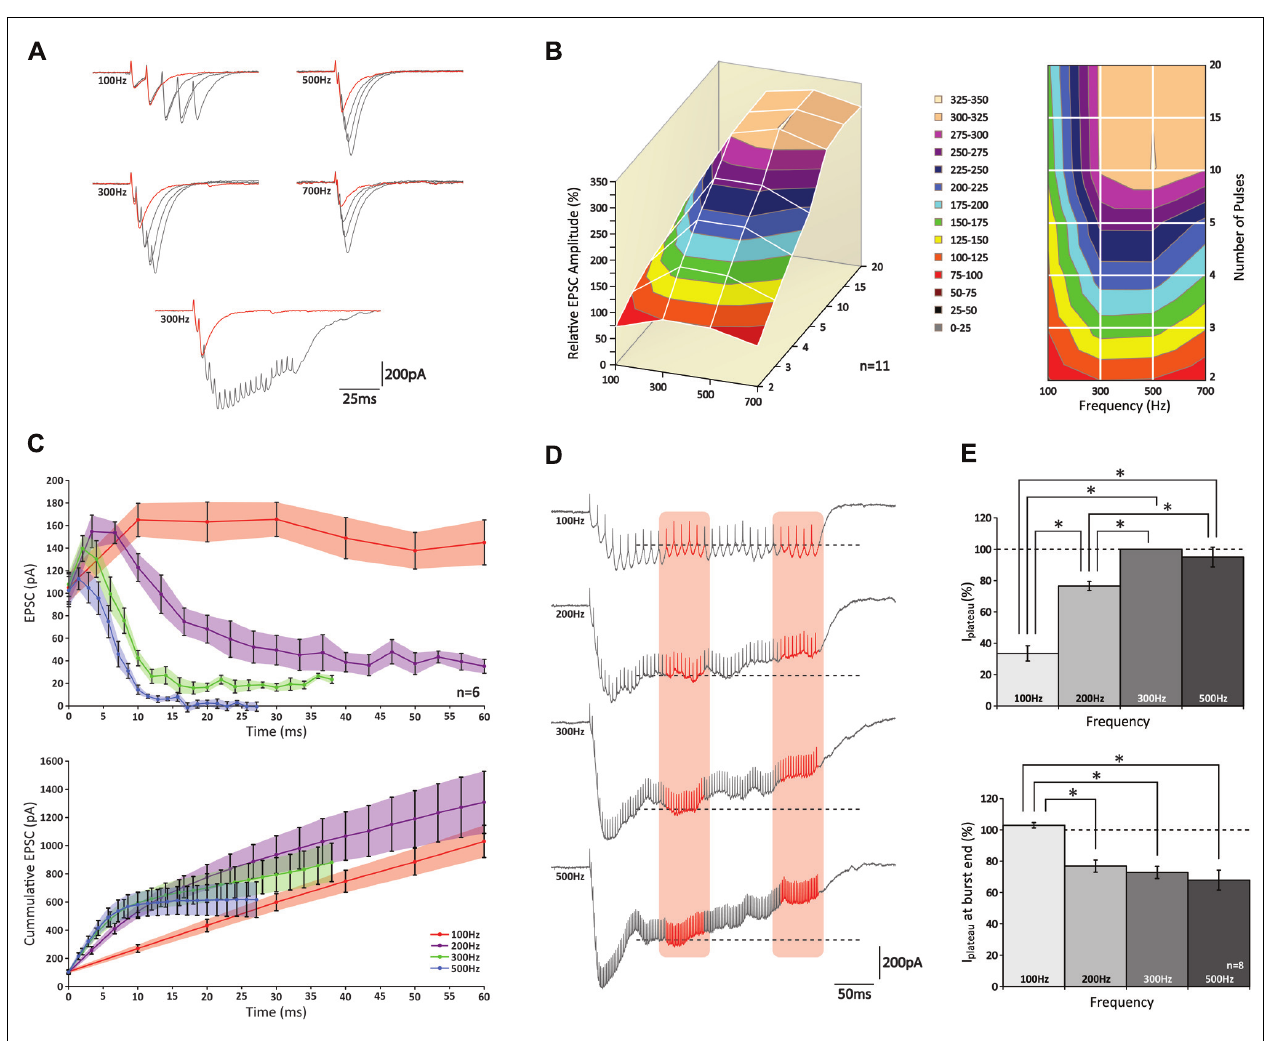
FIGURE 2 | PCs can increase the peak amplitude of their EPSCs following high-frequency stimulation of groups of PFs up to 300 Hz. (A) (top)Traces of PC EPSCs following stimulus bursts of 2, 3, 4, or 5 stimuli at 100, 300, 500, or 700 Hz. Response to two stimuli is shown in red for reference. Note the effect of temporal summation on peak amplitude at higher frequencies. (bottom) Recordings of 2 and 20 stimuli at 300 Hz. Note how in the last half of the long burst no robust responses can be distinguished. (B) 3D representation (left) and top-down view (right) relative peak amplitudes of EPSCs with respect to different stimulus conditions. No increase in EPSC amplitude was observed for bursts of more than 10 stimuli at any of the stimulus frequencies ( p > 0.05). (C) Relative EPSC increases per stimulus